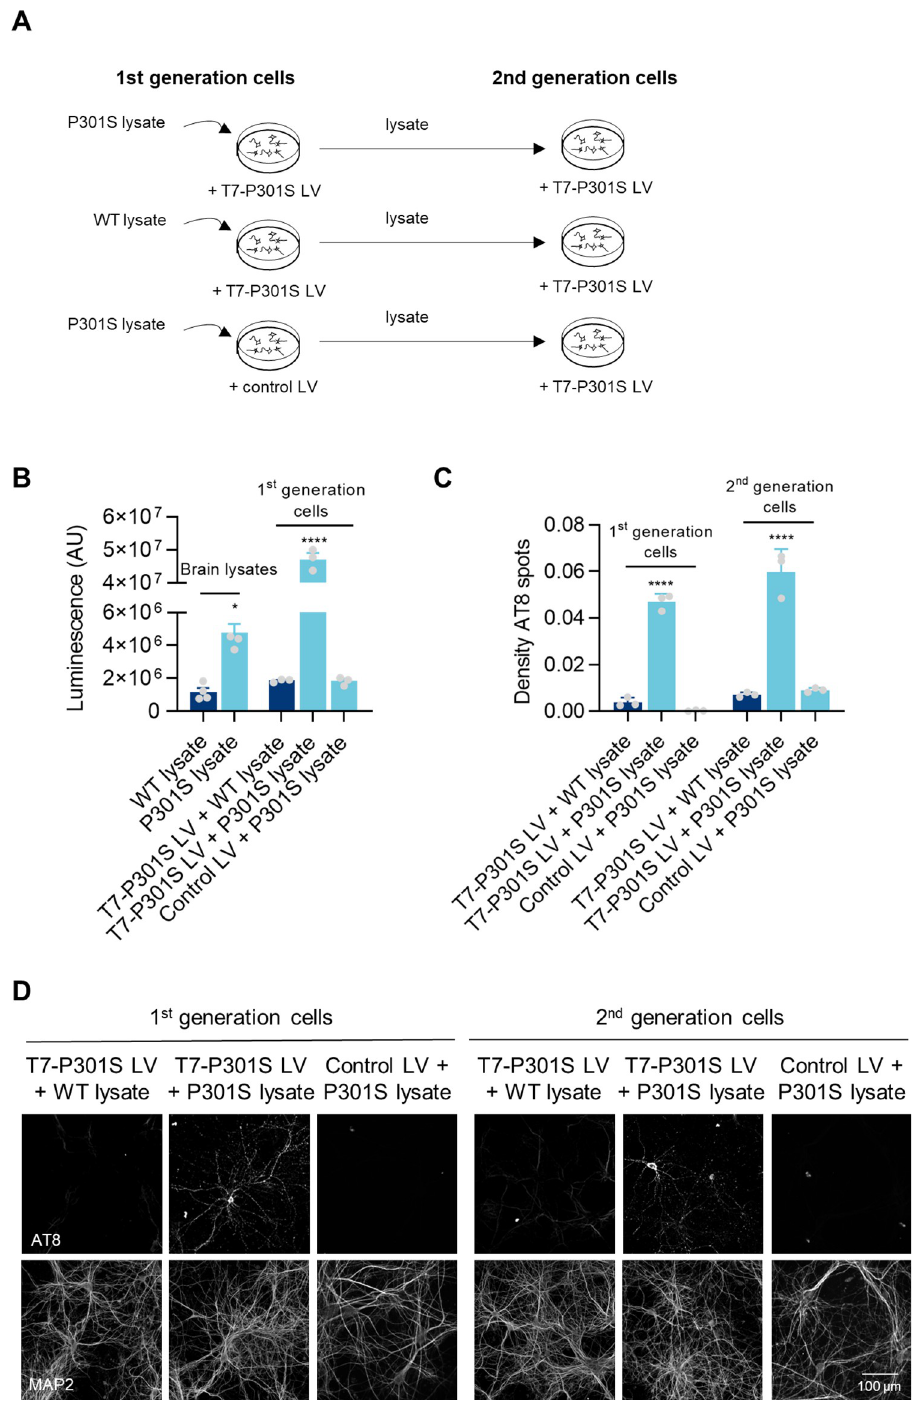
Fig 4. Second generation seeding. A) Diagram of experimental design. 1 st generation of hTau primary neurons were transduced at DIV4 with T7-P301S LV or Control LV at MOI 5 and incubated at DIV7 with 166.6 pg/cell of WT or P301S lysates, up to DIV18. 2 nd generation of hTau primary neurons were transduced at DIV4 with T7-P301S LV at MOI 5 and incubated at DIV7 with lysates of 1 st generation seeded hTau primary neurons at MOS 166.6 pg/cell, up to DIV18. B) Biosensor Assay measuring original WT and P301S lysates (brain lysates) and lysates from the 1 st generation of hTau primary neurons (1 st generation cells). Data shown as mean ± SEM. Brain lysates: n = 4